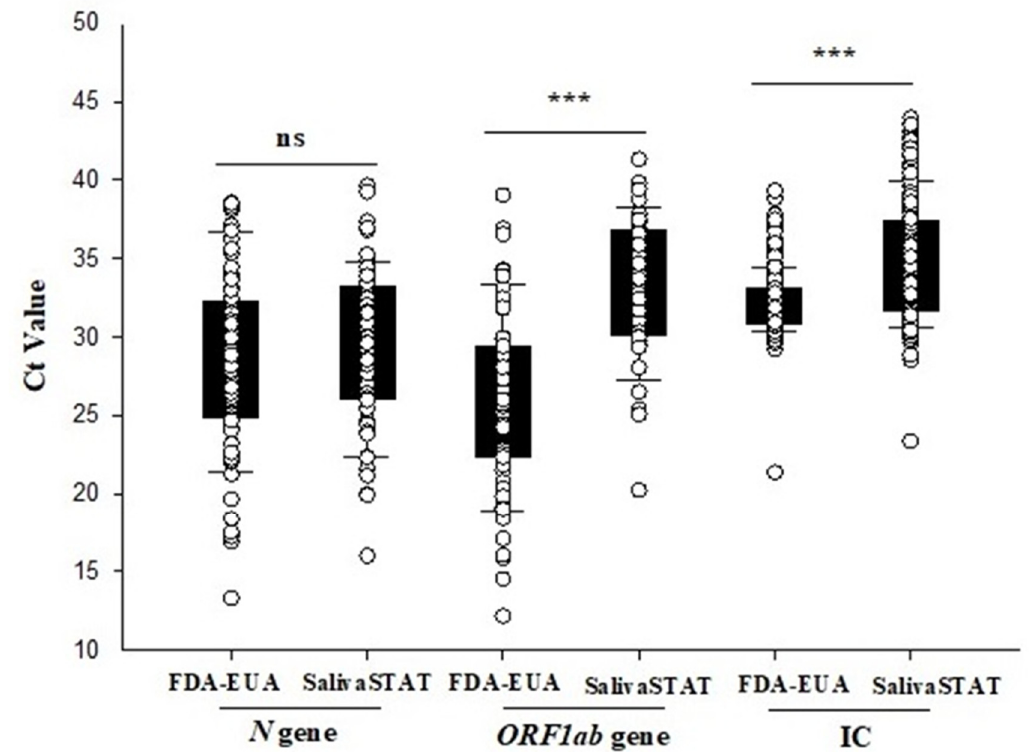
Figure 4. Comparison of Ct values for N , ORF1ab genes, and IC of 600 saliva samples evaluated with FDA-EUA (RNA extraction and RT-PCR) method and SalivaSTAT (Direct RT-PCR) method. *** p < 0.001.